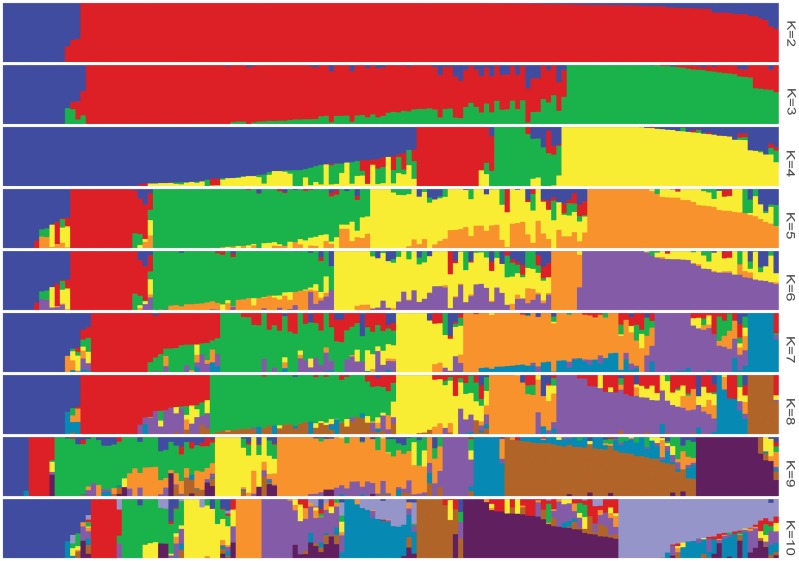
The population structure of the Ting’s rice core collection of landraces. The height of each bar represents the membership probability of one genotype assigned to different subgroups.